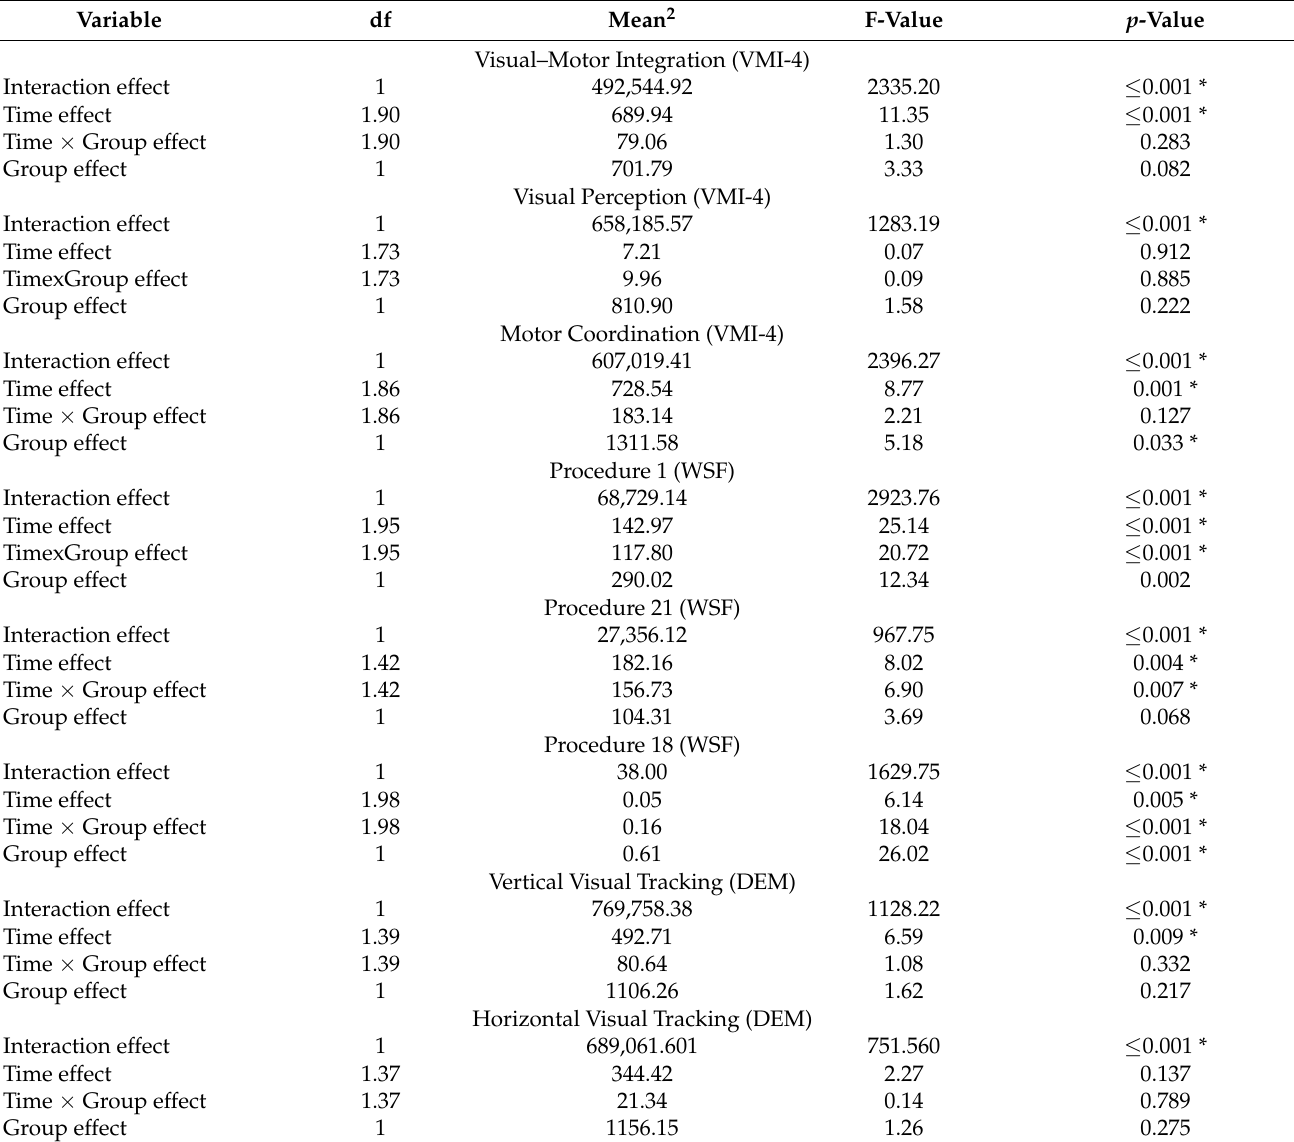
Table 2. Effect of the sport vision program on the experimental and control group regarding the VMI-4, WSF and DEM test